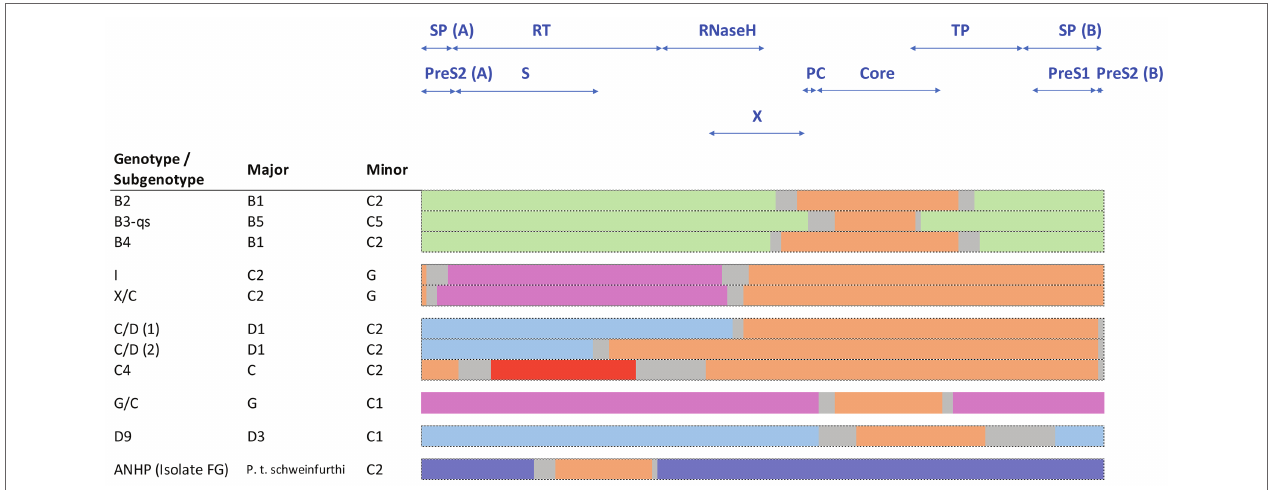
FIGURE 6 | Schematic representation of known HBV genotype C recombinants, showing the conserved regions of the major and minor components. Sequences are color coded by genotype: genotype B (green), C (orange), D (blue), G (pink), J (red), and chimpanzee (purple). The space between the conserved regions is due to uncertainty about the precise recombination breakpoints and is indicated in